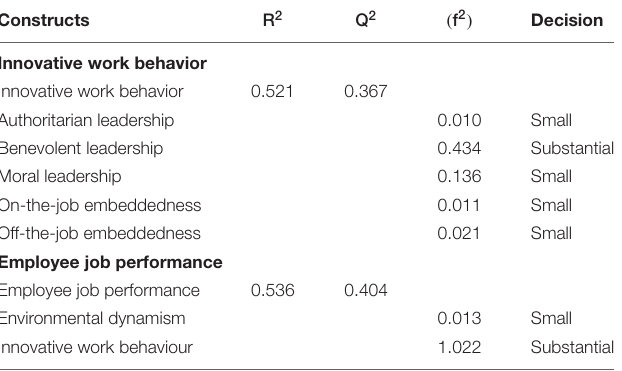
TABLE 6 | Effect size analysis f 2 and predictive relevance Q 2